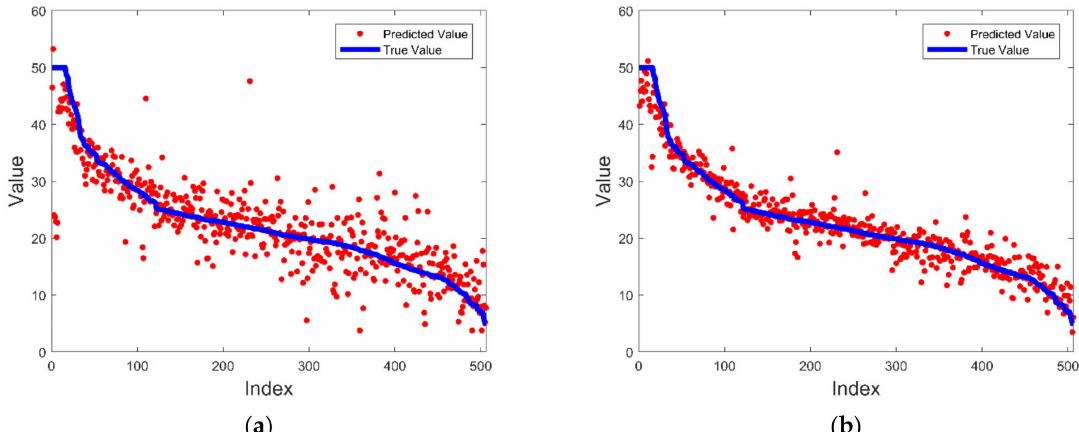
Figure 6. Boston housing dataset prediction results obtained with the models fused with the 0–1 type spatial weight matrix: